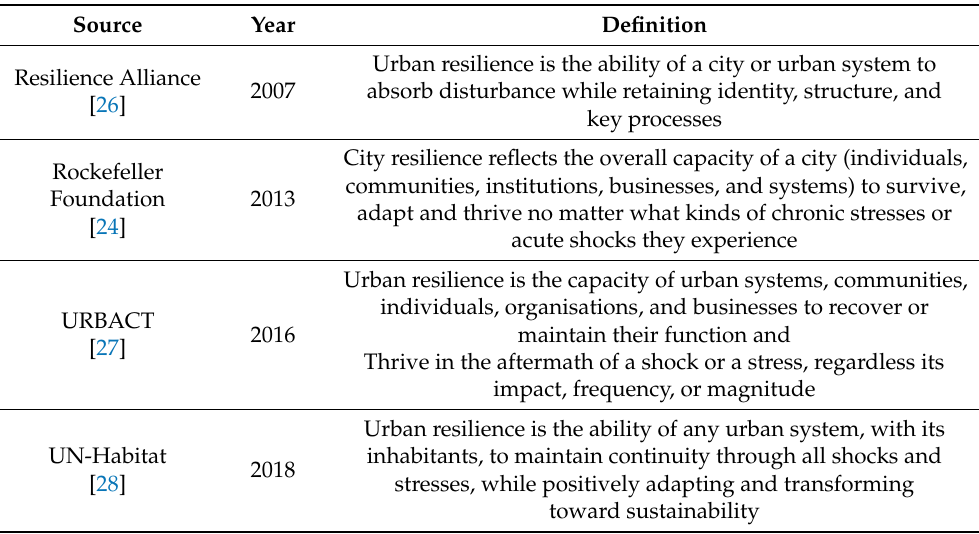
Table 1. Literature review on urban resilience definition. Source: Authors’ elaboration (2022) from the literature review